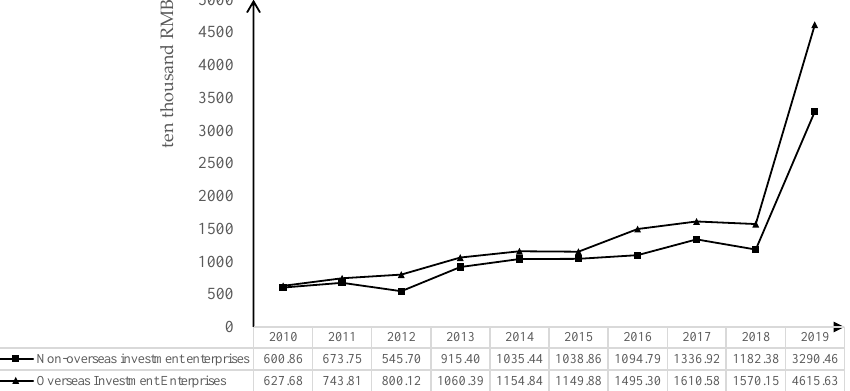
Figure 1. Trends in environmental expenditures of Chinese companies, 2010 – 2019. Data source: The annual reports of Chinese enterprises and the CSMAR database.